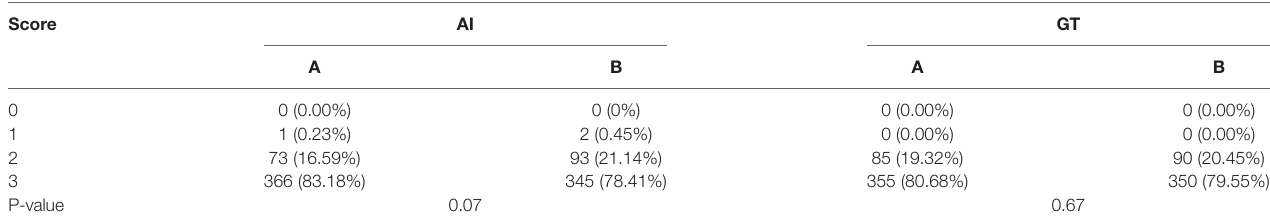
TABLE 6 | Mean clinical score of GTV by two oncologists.